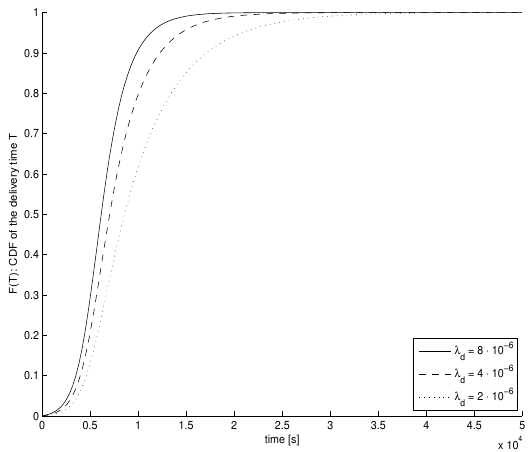
Figure 8: Number of recovered nodes vs time for a single plasmid dissemination with a single attractant ing a topology with 3 nodes and we derived the numerical solution. The model showed a strong dependence on the inter-contact rate among bacteria and between bacteria and destination. We think that the epidemic approach repre- sents a simple, feasible and reliable solution for modeling of information vive spreading in conjugation-based bacterial